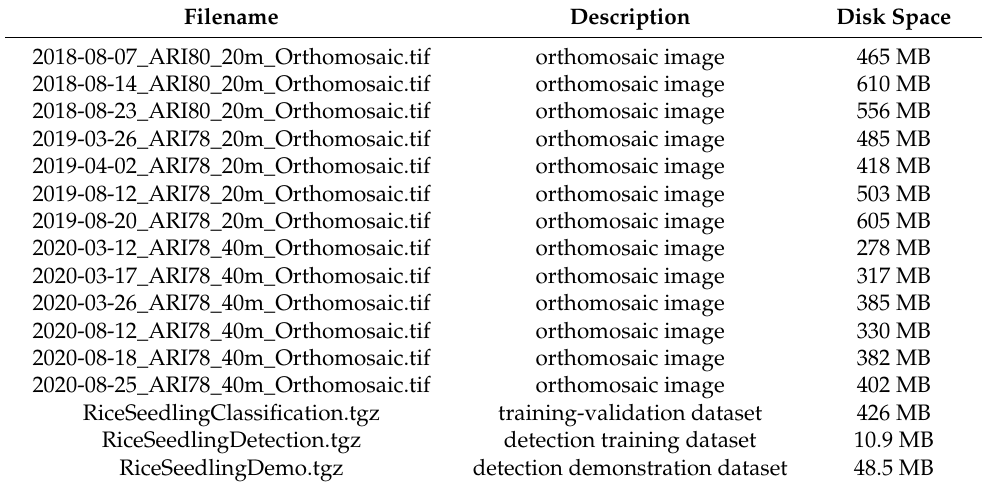
Figure 1. An overview of field No. 80 (cyan bounding area). Image acquired on 7th August 2018. The green bounding area represents the area for training–validation dataset, and the red bounding area represents the area for the object detection demonstration dataset. Table 1. A description of image files published on GitHub.